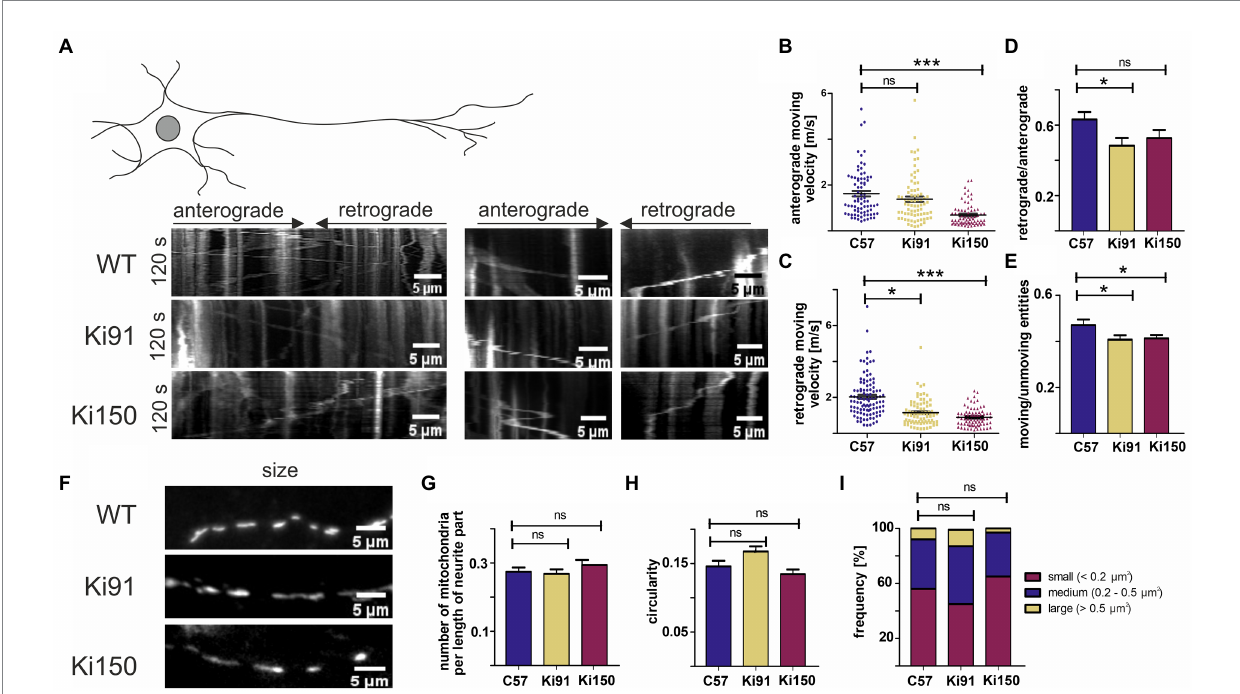
FIGURE 7 Transport of mitochondria is slower in neurites of SCA3 cerebellar neurons in vitro . (A) Representative kymographs of mitochondrial transport in primary cerebellar neurons and pictures of mitochondria size. (B) The average velocity (calculated as travelling distance/time) in the anterograde direction (from soma) was significantly lower in Ki150 neurites in comparison to WT. (C) The average velocity (calculated as travelling distance/time) in the retrograde direction (toward soma) was significantly lower in both Ki91 and Ki150 neurites in comparison to WT. (D) The ratio of mitochondria moving retrogradely to mitochondria moving anterogradely is lower in Ki91 neurites compared to WT. (E) The number of moving mitochondria is significantly lower in both Ki91 and Ki150 neurites as compared to WT. (F) The number of mitochondria per neurite length was not changed. (G) The circularity of mitochondria indicating fusion/fission events is not altered. (H) The average area of mitochondria is approximately the same in all tested groups. (I) The size distribution of mitochondria in Ki91 and Ki 150 cerebellar neurons is comparable to WT. All parameters were quantified using ImageJ. The measurements were from 3 independent experiments, with 15–25 cells analyzed each time. Two-sample t -test (* p < 0.05, ** p < 0.01, *** p < 0.001), error bars: